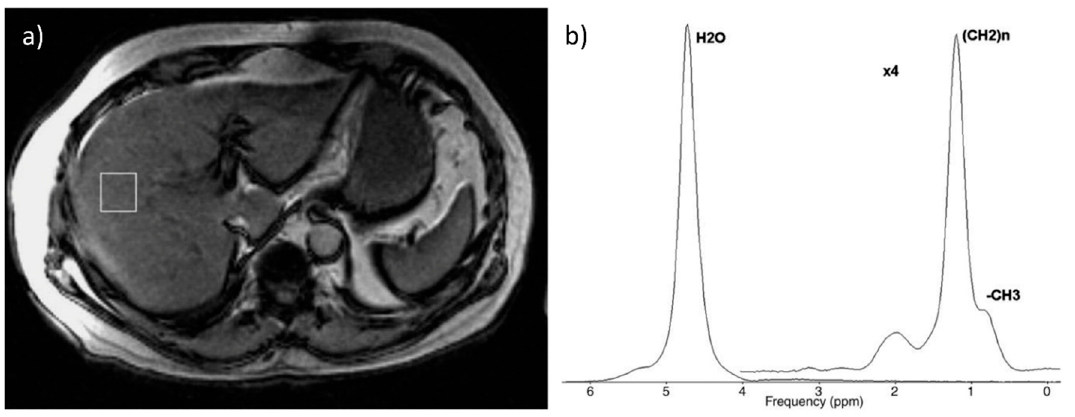
Figure 4. Example of spectroscopic examination: ( a ) voxel located in the right lobe ( b ) corresponding spectrum. Figure from Borra RJ, et al. Nonalcoholic fatty liver disease: rapid evaluation of liver fat